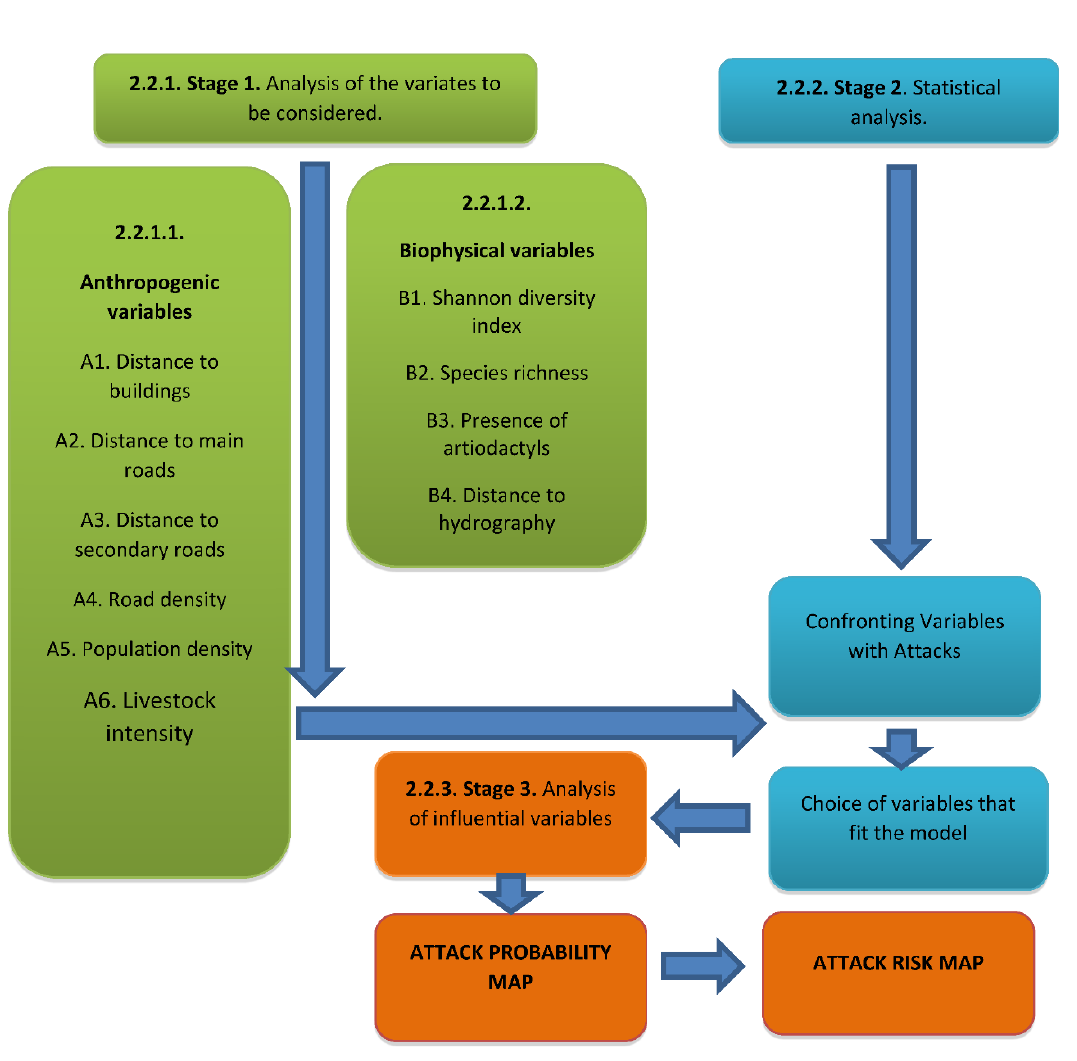
Figure 2. Methodological Flowchart .